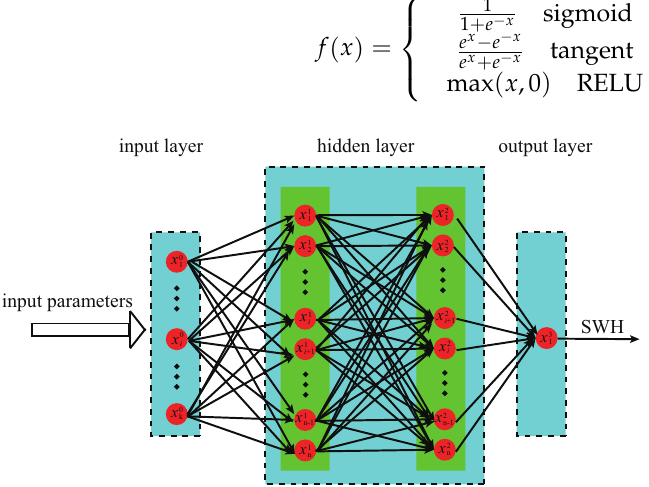
Figure 4. Architecture of the neural network used in this